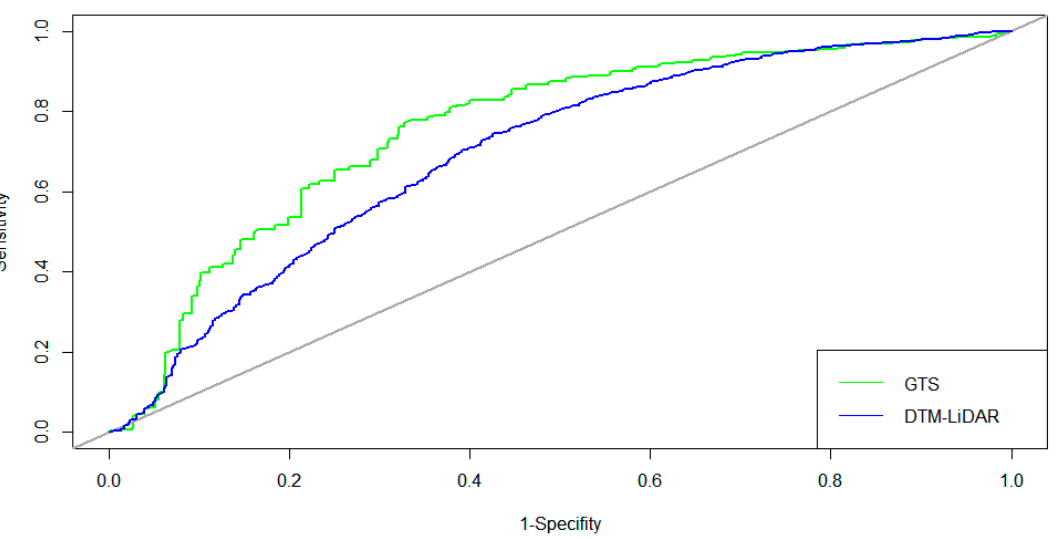
Figure 7. Percentages of catchment area partitioned in five categories of landslide susceptibility based on modelling results.